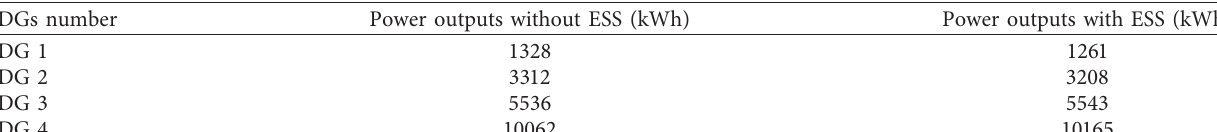
Table 3: Power outputs of DGs with/without ESS.